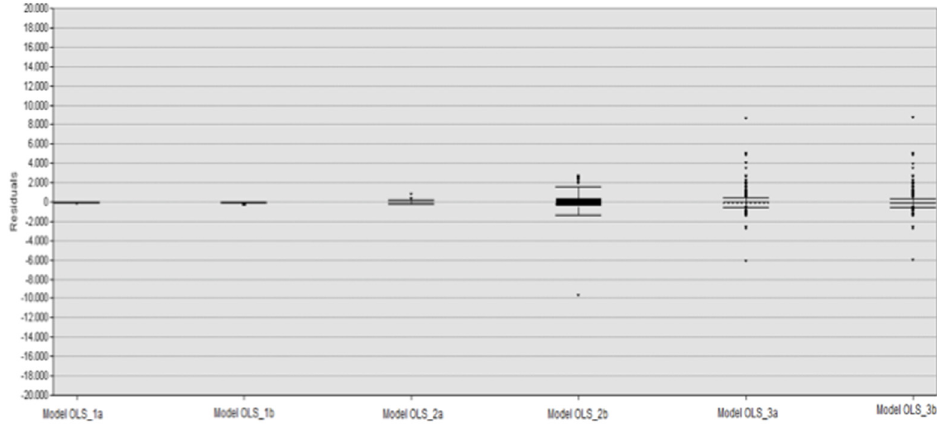
Figure A3. Distribution of errors for each OLS Model.